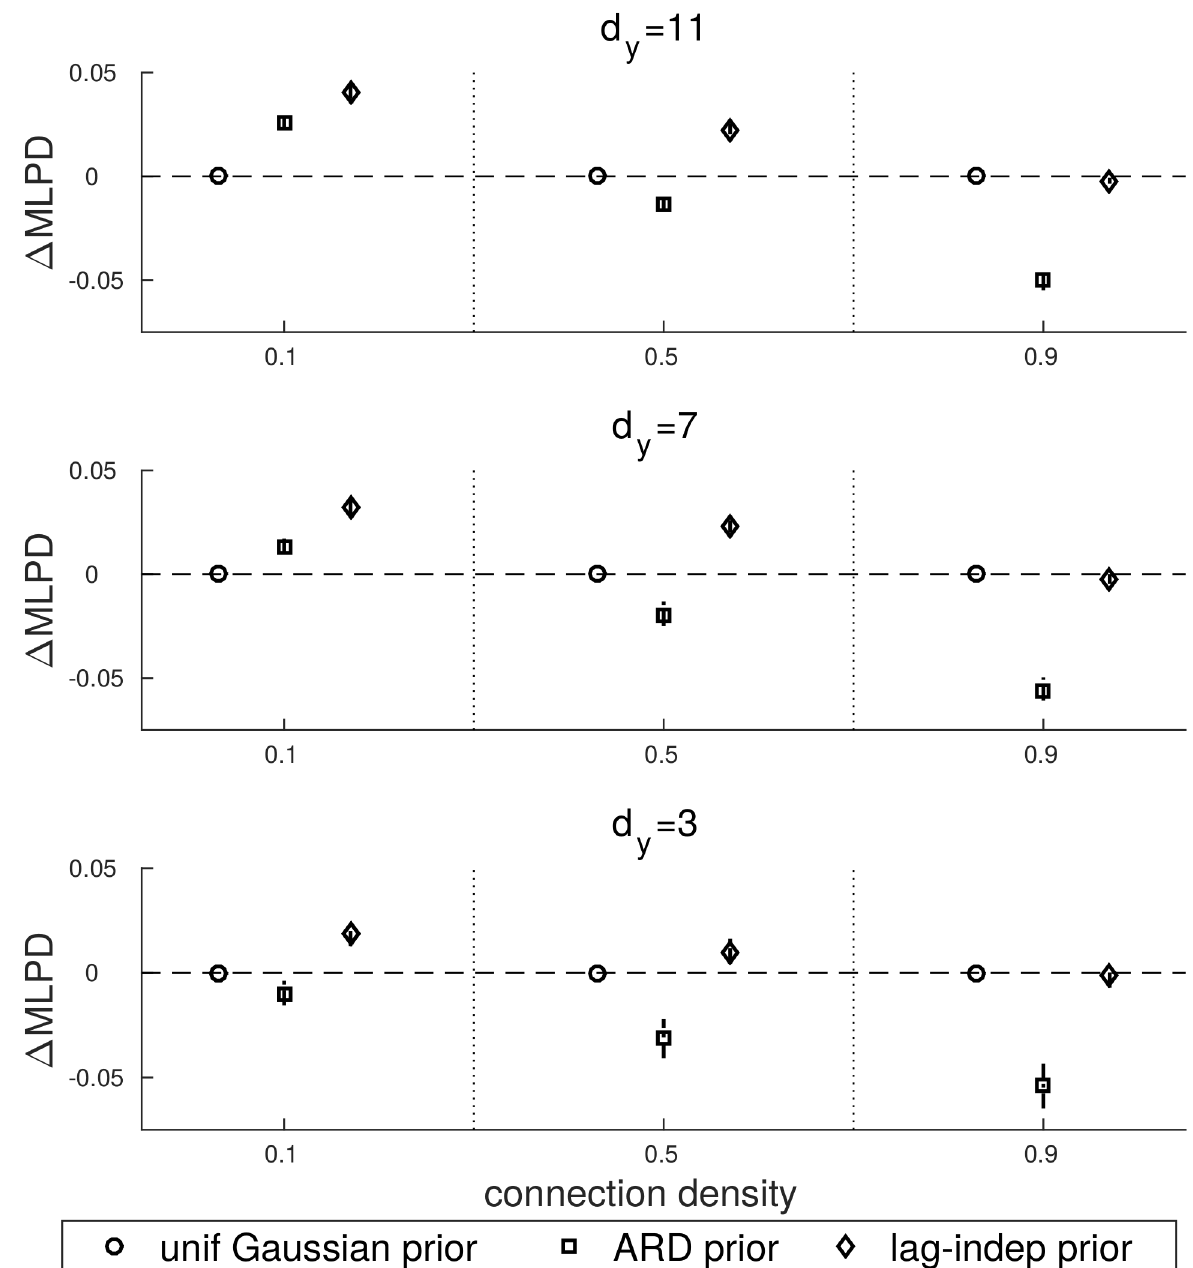
Fig 5. Δ MLPD computed with respectto the uniform Gaussian prior and evaluated on the test